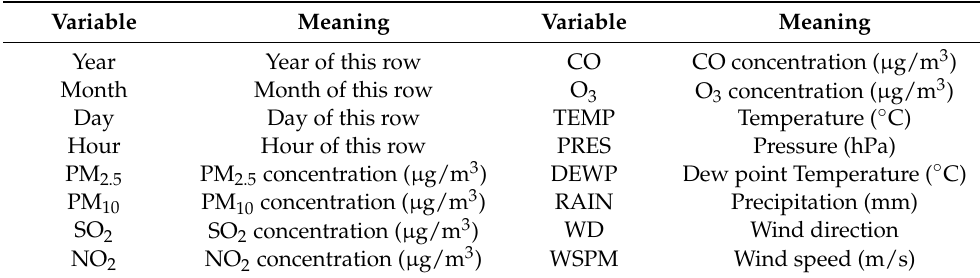
Table 1. Variable